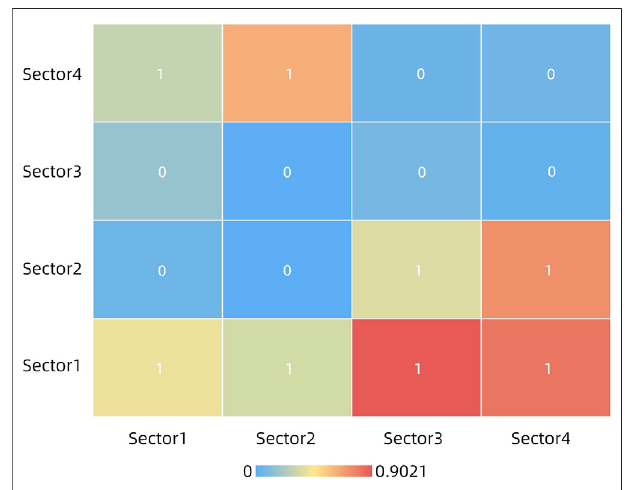
FIGURE5| Densitymatrixandimagematrixofthespatialnetworkofthe information entropy of the carbon emission structure in China